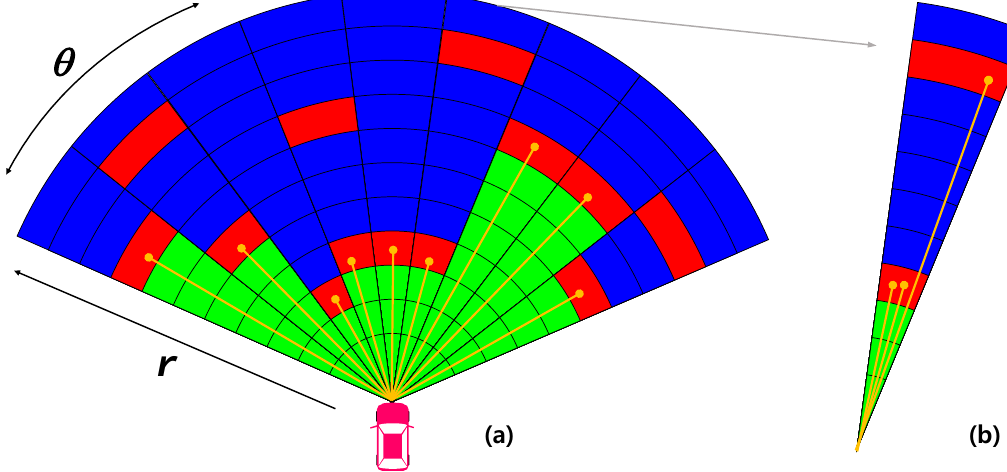
Figure 2. Local EOGM generated from the LiDAR ( F : green, O : red, Ω : blue). ( a ) Local EOGM in polar coordinate, ( b ) Unit polar